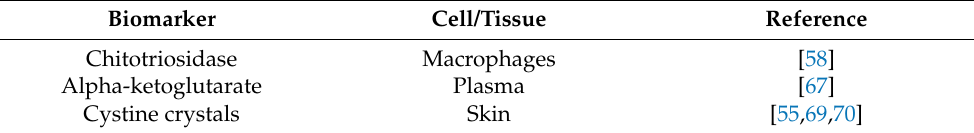
Table 2. Novel biomarkers for determination of cystine content in cells and